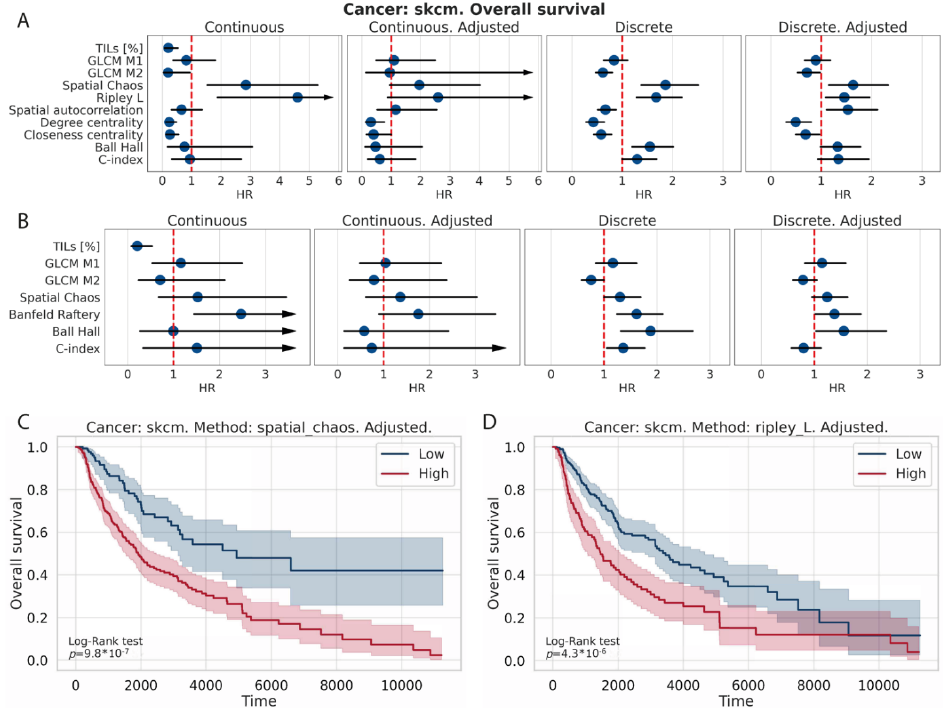
Figure 5. Detailed survival analysis results for skcm cancer type. Forest plots compare hazard ratios with confidence intervals between spatial measures for each Cox model type and measure scale separately for binary TIL maps ( A ) and probabilities ( B ). Kaplan–Meier curves of selected discretized spatial measures for adjusted model: spatial chaos ( C ) and Ripley’s L ( D ).